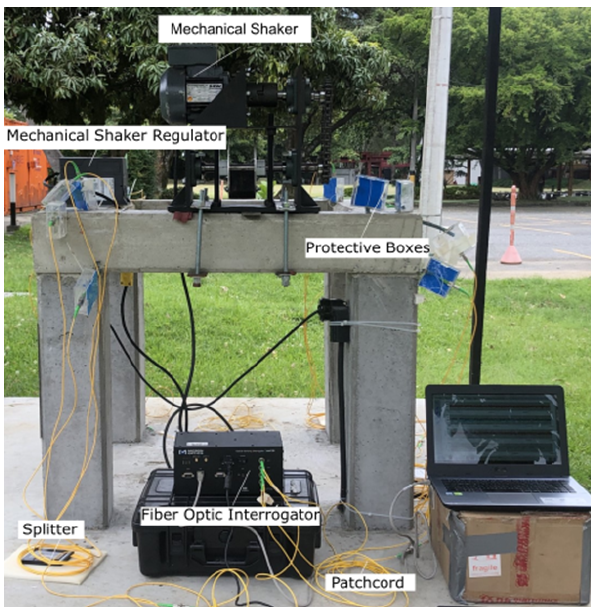
Figure 7. Experiment